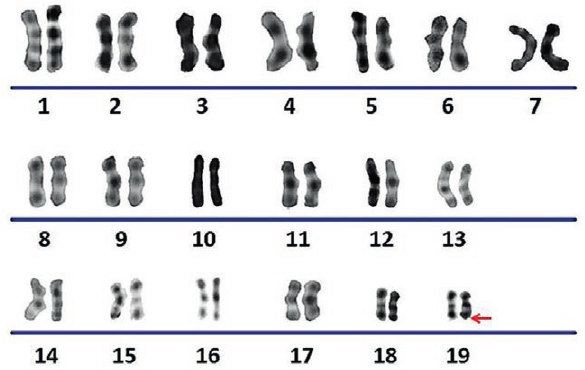
Figure 3. Karyotype of Dasylirion cedrosanum Trel. stained with GTG banding. The pattern of bands in each chromosome and the dark bands in the telomeric region (arrow) are shown.